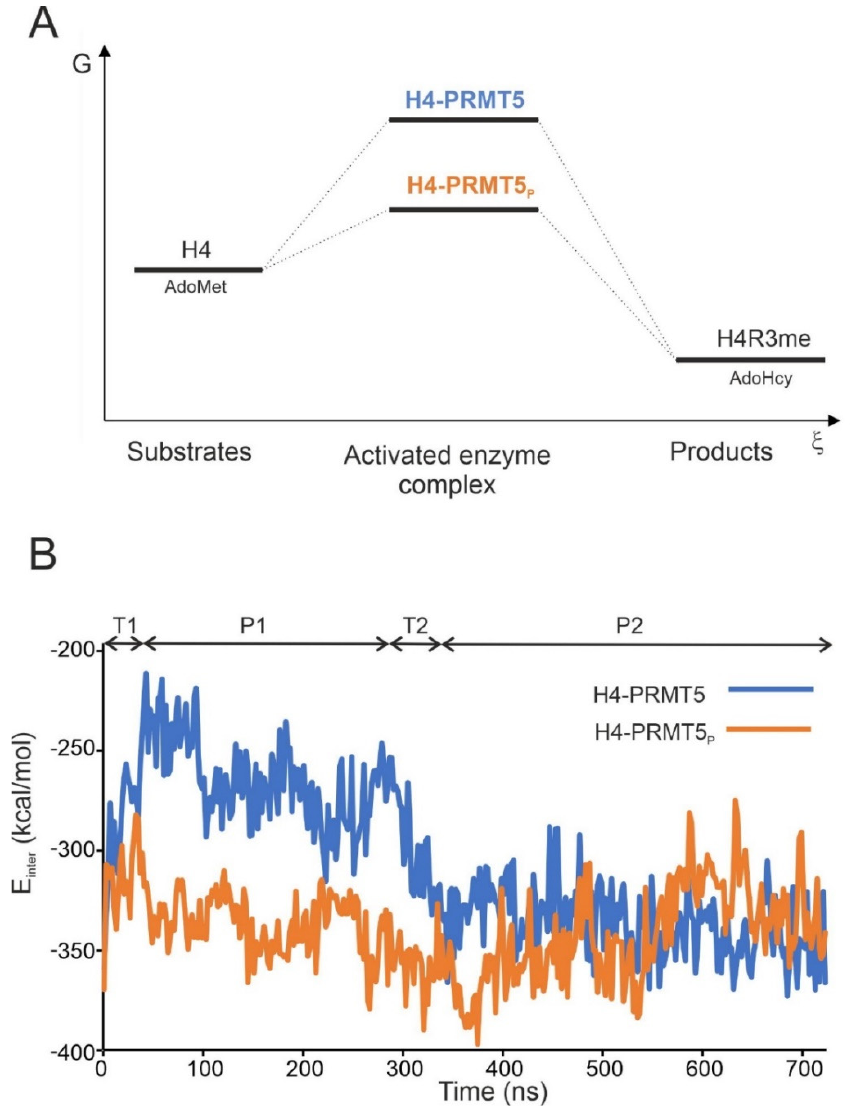
Figure 2. ( A ) Schematic free energy (G) vs. reaction coordinate ( ξ ) profile of human PRMT5-catalysed methylation of histone H4. Substrate histone H4 peptide and the methyl donor S-adenosyl-L-methionine (AdoMet) are marked. The free energy of the activated enzyme complexes is relatively high. However, the phosphorylated enzyme complex (H4-PRMT5 P , orange) has to cross a lower energy barrier than the unmodified complex (H4-PRMT5, blue). Products R3-methylated histone H4 (H4R3me) and S-adenosyl-L-homocysteine (AdoHcy) are also shown; ( B ) intermolecular interaction energy (E inter ) changed during the 720 ns-long MD simulation for the unmodified (H4-PRMT5, blue) and the T80-phosphorylated (H4-PRMT5 P , orange) enzyme complexes. The plot includes two transient (T1, T2) and two plateau (P1, P2) regions. T1 is an equilibration section for the conformational optimalization, while T2 refers to the energy drop between the activated (P1) and the pre-product (P2) states of the enzyme–substrate complexes.